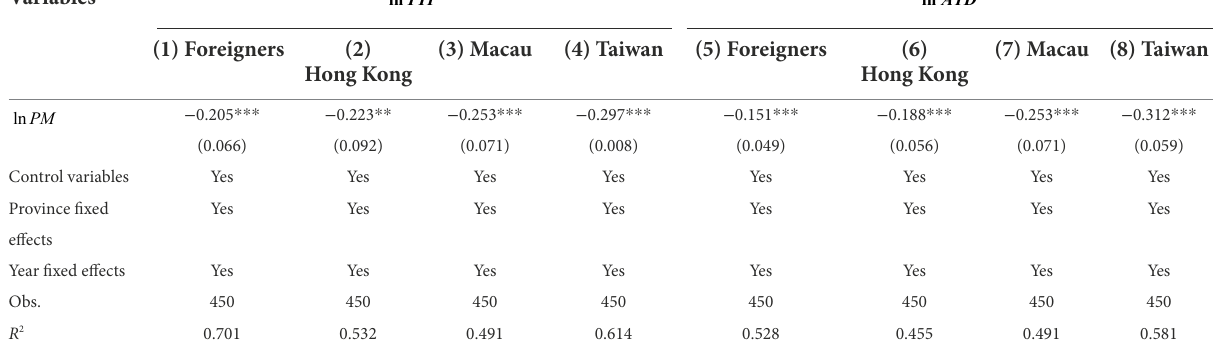
TABLE 5 Regression results based on the tourism market structure.